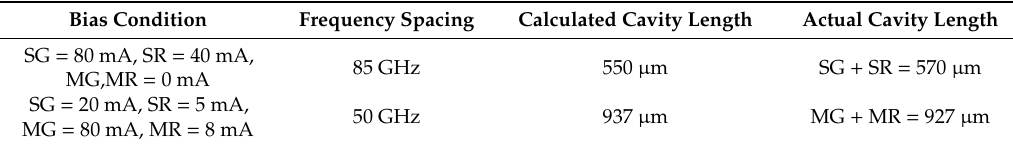
Table 2. Cavity length correpondence calculation.